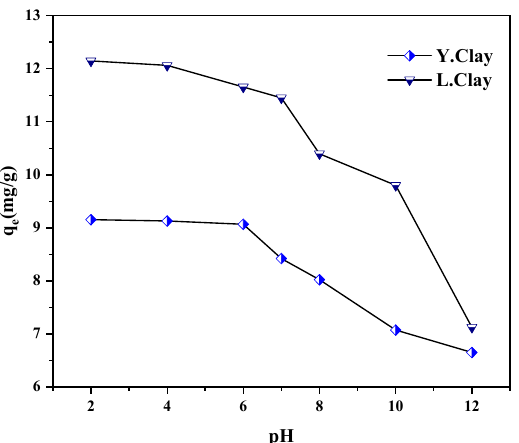
Figure 6. Effect of pH; Conditions: t = 10 min for Y. Clay/15 min for L. Clay, m = 0.01 g, C = 12 mg/L,